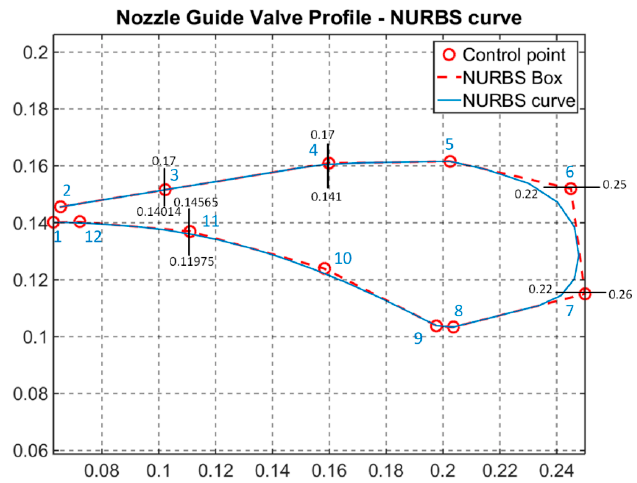
Figure 7. NURBS curve generated from 12 control points.